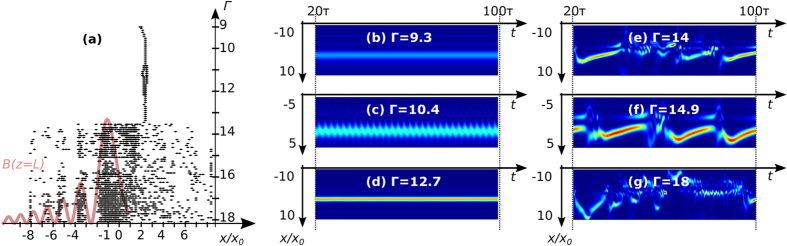
Spatiotemporal dynamics of two counterpropagating Airy beams in a long crystal L =  5.5Ld, with the normalized intensities
. (a) Bifurcation diagram of the transverse output position of the forward off-shooting soliton at z = L, with the transverse normalized intensity profile of backward Airy beam at z = L. (b–g) Temporal evolution of the transverse output position of the forward off-shooting soliton at z = L: (b) steady-state (Γ = 9.3), (c) sinusoidal oscillations (Γ = 10.4), (d) second steady-state (Γ = 12.7), (e) first instabilities (Γ = 14), (f) periodical non-sinusoidal oscillations (Γ = 14.9) and (g) instabilities (Γ = 18). E.g. experimentally for CP Airy beams in a SBN:75 crystal (L*5mm*5mm) with x0 = 10μm: L = 28mm, Uext ∈ [500V, 900V].